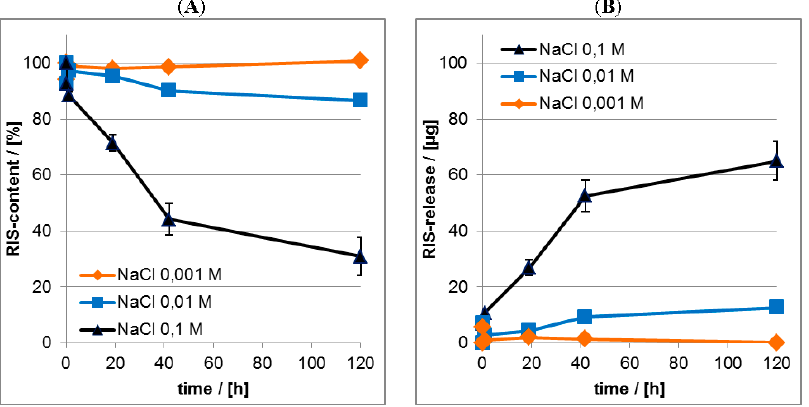
Figure 14. ( A ) Release kinetics from RIS/PEC in dependence of salt concentration—ATR-FTIR data; ( B ) Release kinetics from RIS/PEC in dependence of salt concentration—UV/VIS data.